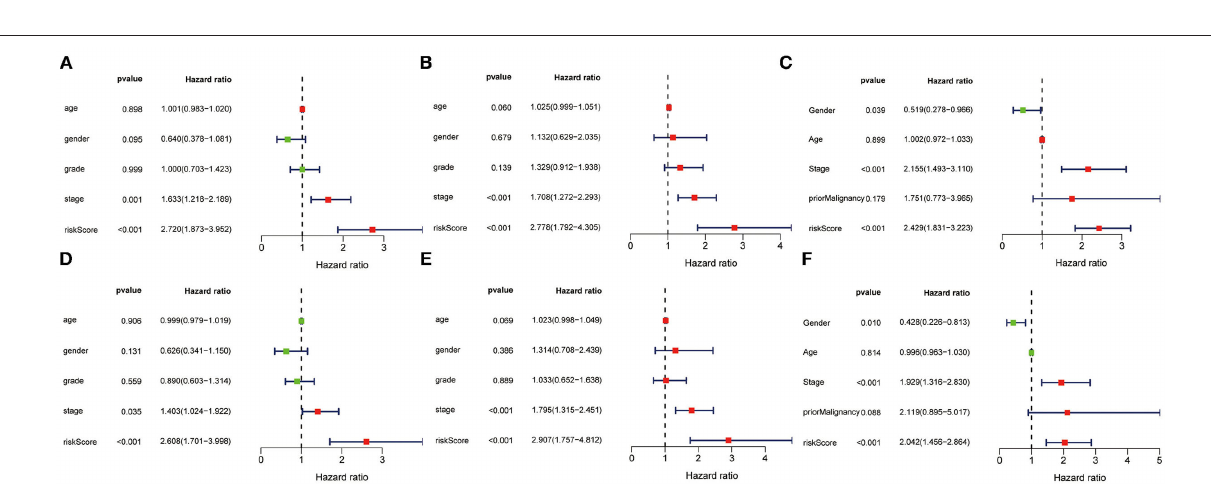
FIGURE 11 | Univariate and multivariate analysis of 3-gene signature and clinical characteristics in the training, validation and testing set. Univariate analysis of 3-gene signature and clinical characteristics in the training (A) , validation (B) and testing set (C) . Multivariate analysis of 3-gene signature and clinical characteristics in the training (D) , validation (E) and testing set (F)